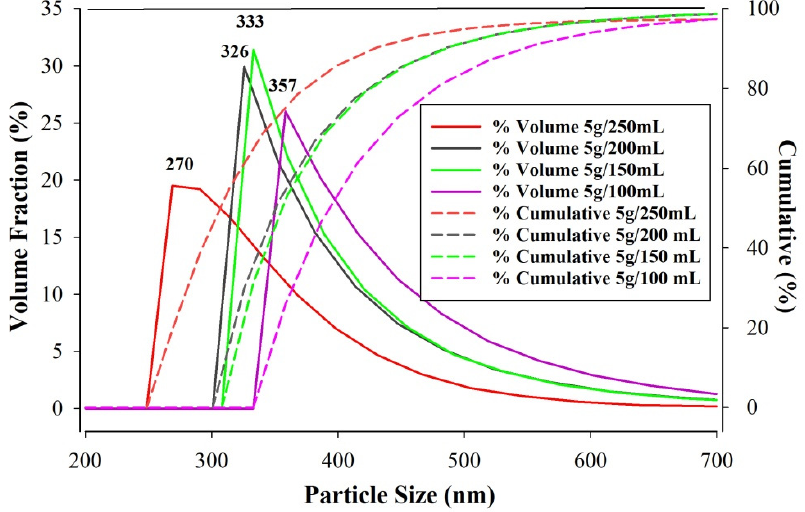
Figure 8. Effect of particle density on the particle size distribution of BaFe 11.2 Mg 0.4 Al 0.4 O 19